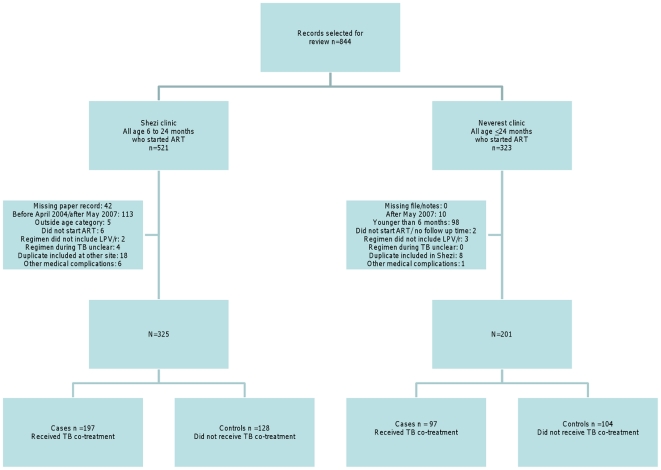
Flow diagram of study participants.